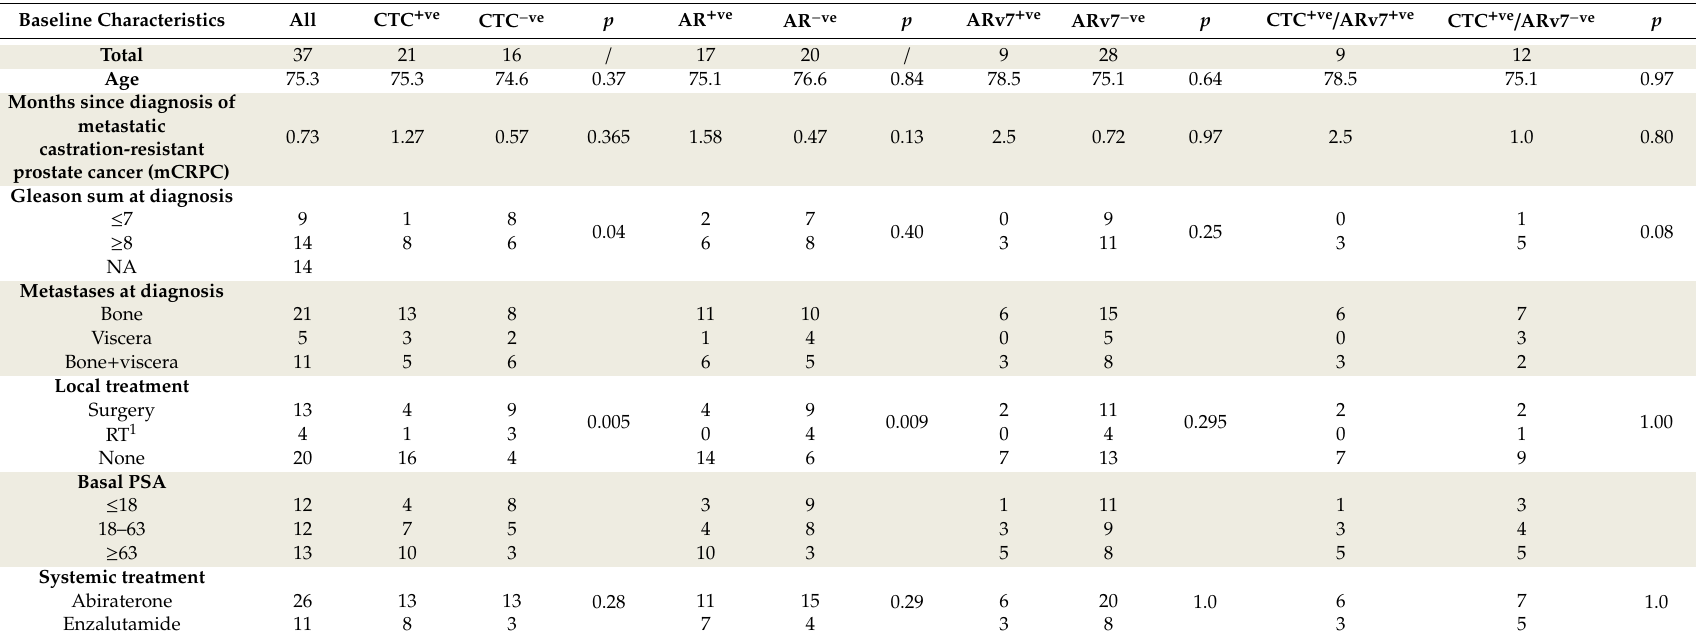
Table 1. Liquid biopsy variables according to patient baseline demographic and clinical